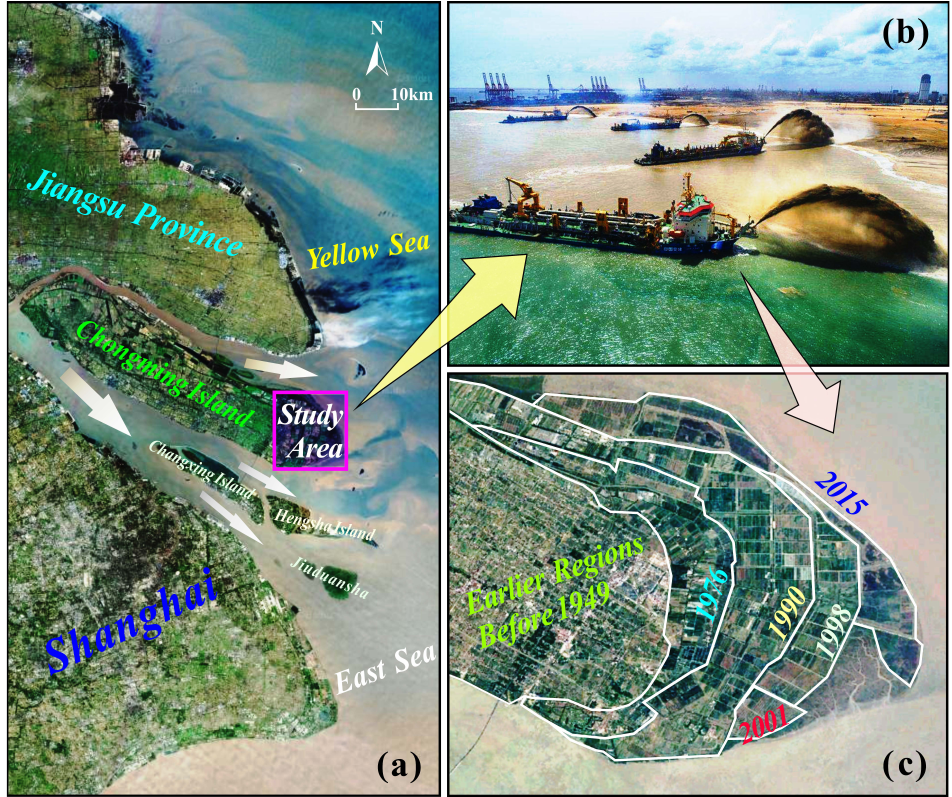
Figure 1. An overview of the study area: ( a ) Shanghai city and the northeastern study area; ( b ) hydraulic reclamation; ( c ) expansion map of Chongming East